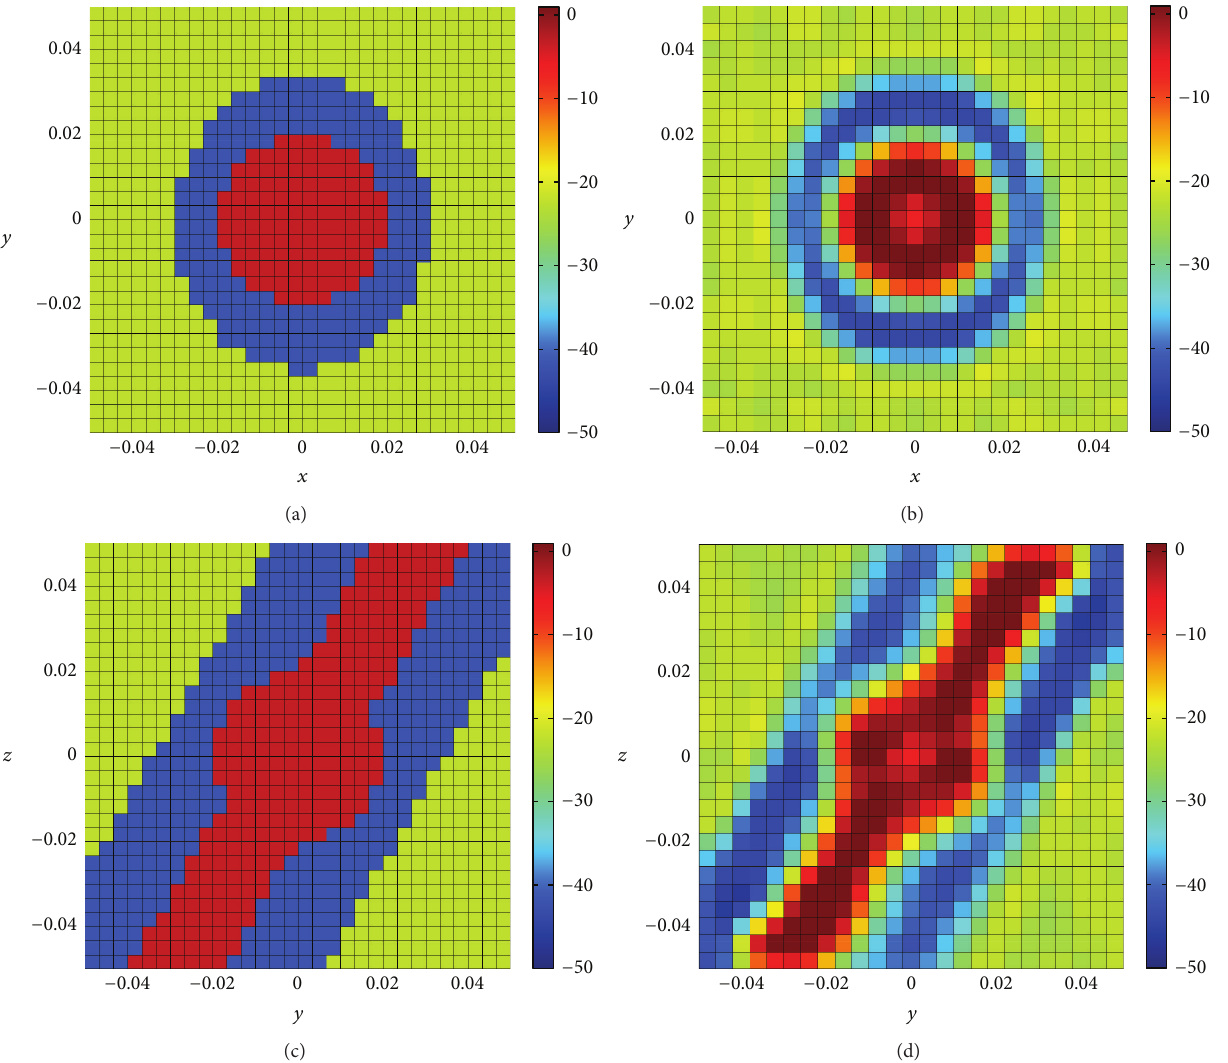
Figure 9: Imaginary part of the exact permittivity used to simulate the data at 1GHz without added noise (left) and of the reconstructed permittivity on the coarser grid (right) for the child’s arm phantom, in the 𝑥𝑦 -plane (top) and 𝑦𝑧 -plane (bottom). Distances are in m.